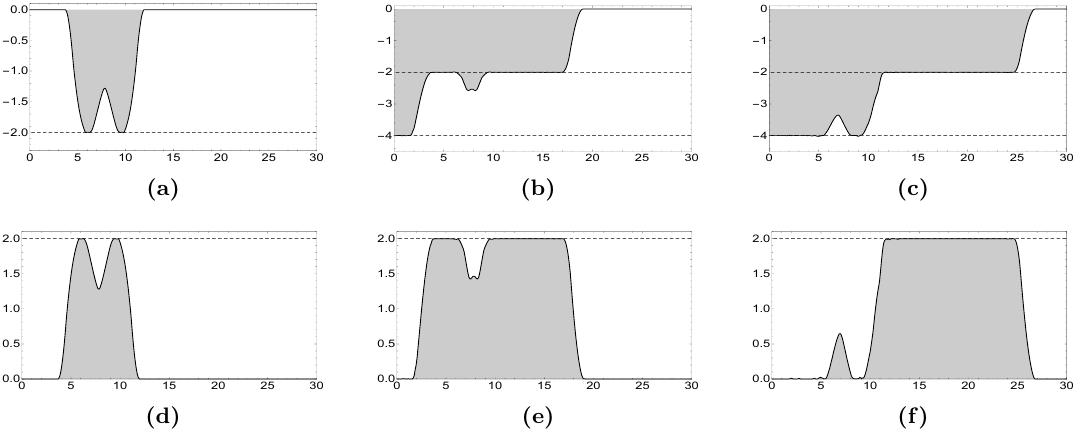
Figure 30. The shell-type structure containing kinks at R + for l = 5 : 224 at (a,d) t =, (b,e) t =, (c,f) t =. Figures (d,e,f) represent folded (original) (cid:12)eld (cid:22) (cid:17) ( t; x ).